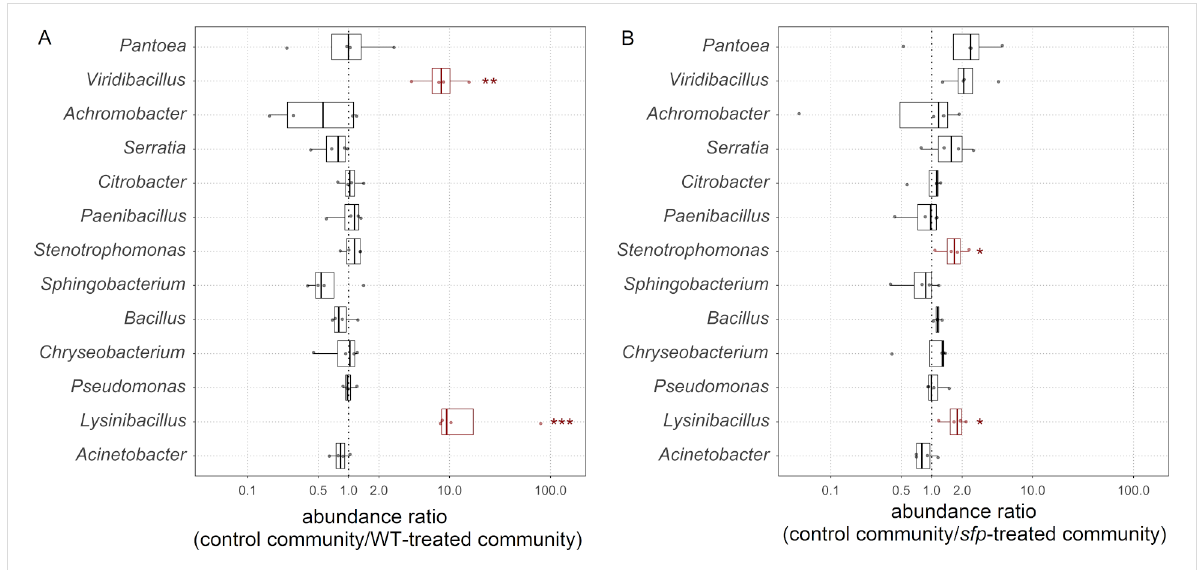
Figure 5: Abundance ratios for each genus and replicate (points) in the control community compared to the WT-treated (A) and to the sfp -treated community (B). Red-box plots highlight the statistical significance, which is defined as P ≤ 0.05 (*), P ≤ 0.01 (**), and P ≤ 0.001 (***).